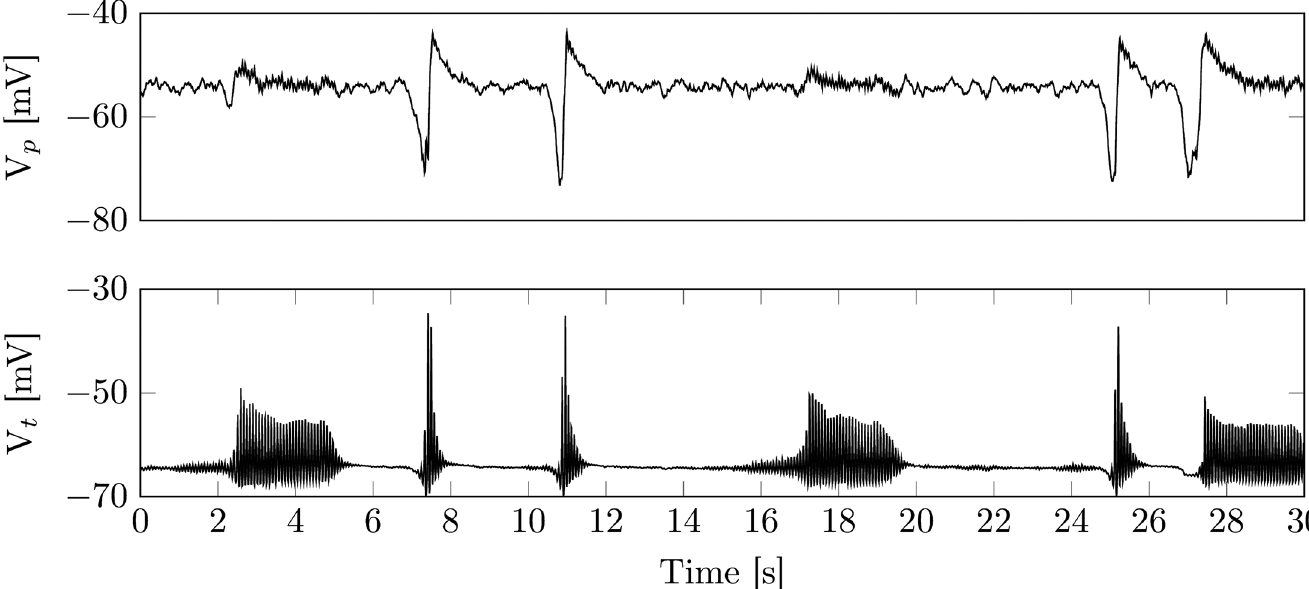
Fig 4. Example time series of sleep stage N2. Shown are membrane voltages of the cortical pyramidal (top) and the thalamic relay population (bottom). The spindle oscillations induced within the thalamic module project into the cortical module. While the spindle oscillations are generally induced by fluctuations in background noise, there is also a grouping between cortical KCs and thalamic spindles (see 7s-9s and 19s-21s). The grouping stems from the lack of depolarizing input during a cortical KC. Parameters are as in Table 2.